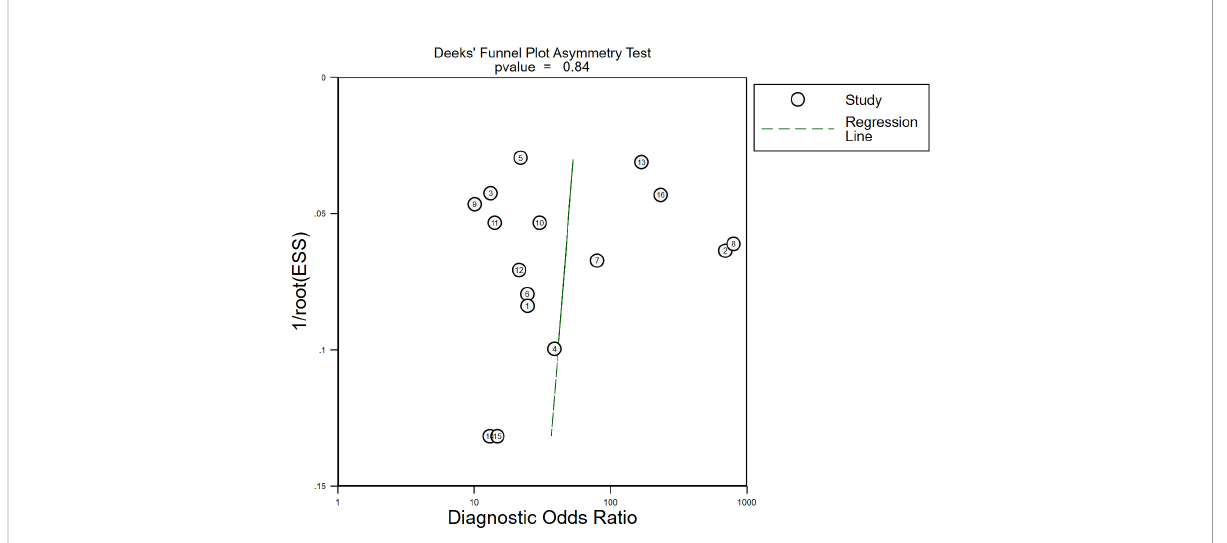
FIGURE 6 The publication bias of the included studies. No signi fi cant publication bias was found in the present meta-analysis. Each circle represented eligible research. ESS, effective sample size.